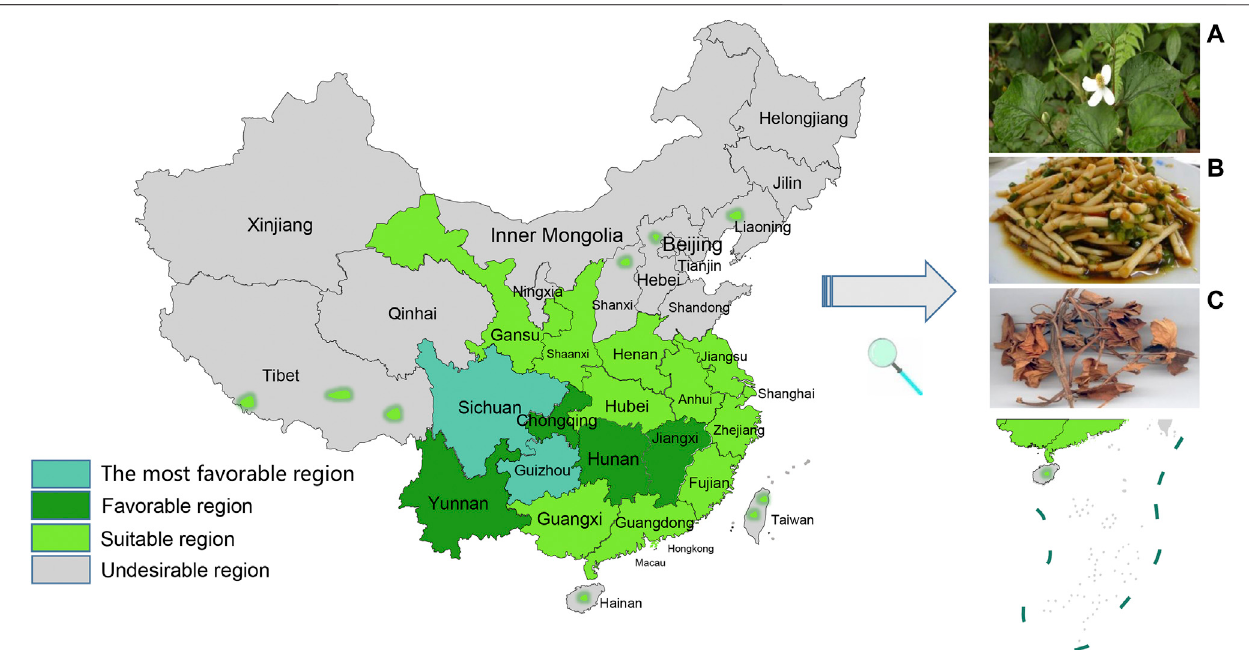
FIGURE1| Climaticandecologicaladaptabilitydistributionof H.cordata inChina (A) fl owersof H.cordata (B) rootsof H.cordata asfood (C) above-groundpartof dry stems and leaves of H. cordata .